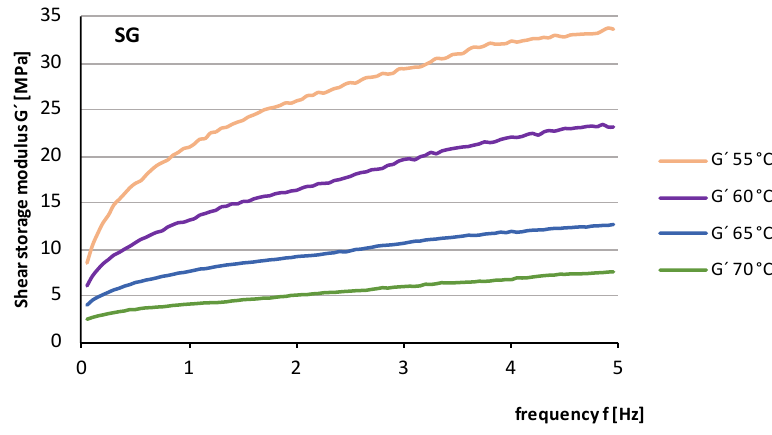
Fig. 12 Storage modulus-frequency curves of representative SG interlayer in high temperatures obtained by DMTA.